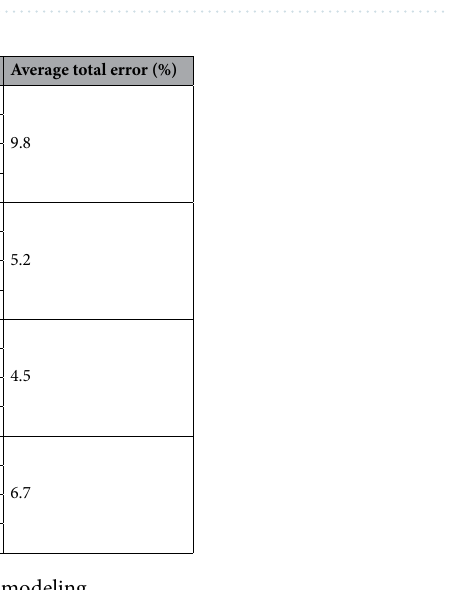
Figure 9. Solubility parameter changes against solvent ratio for different oil samples at 20,000 ppm concentration of inhibitors.